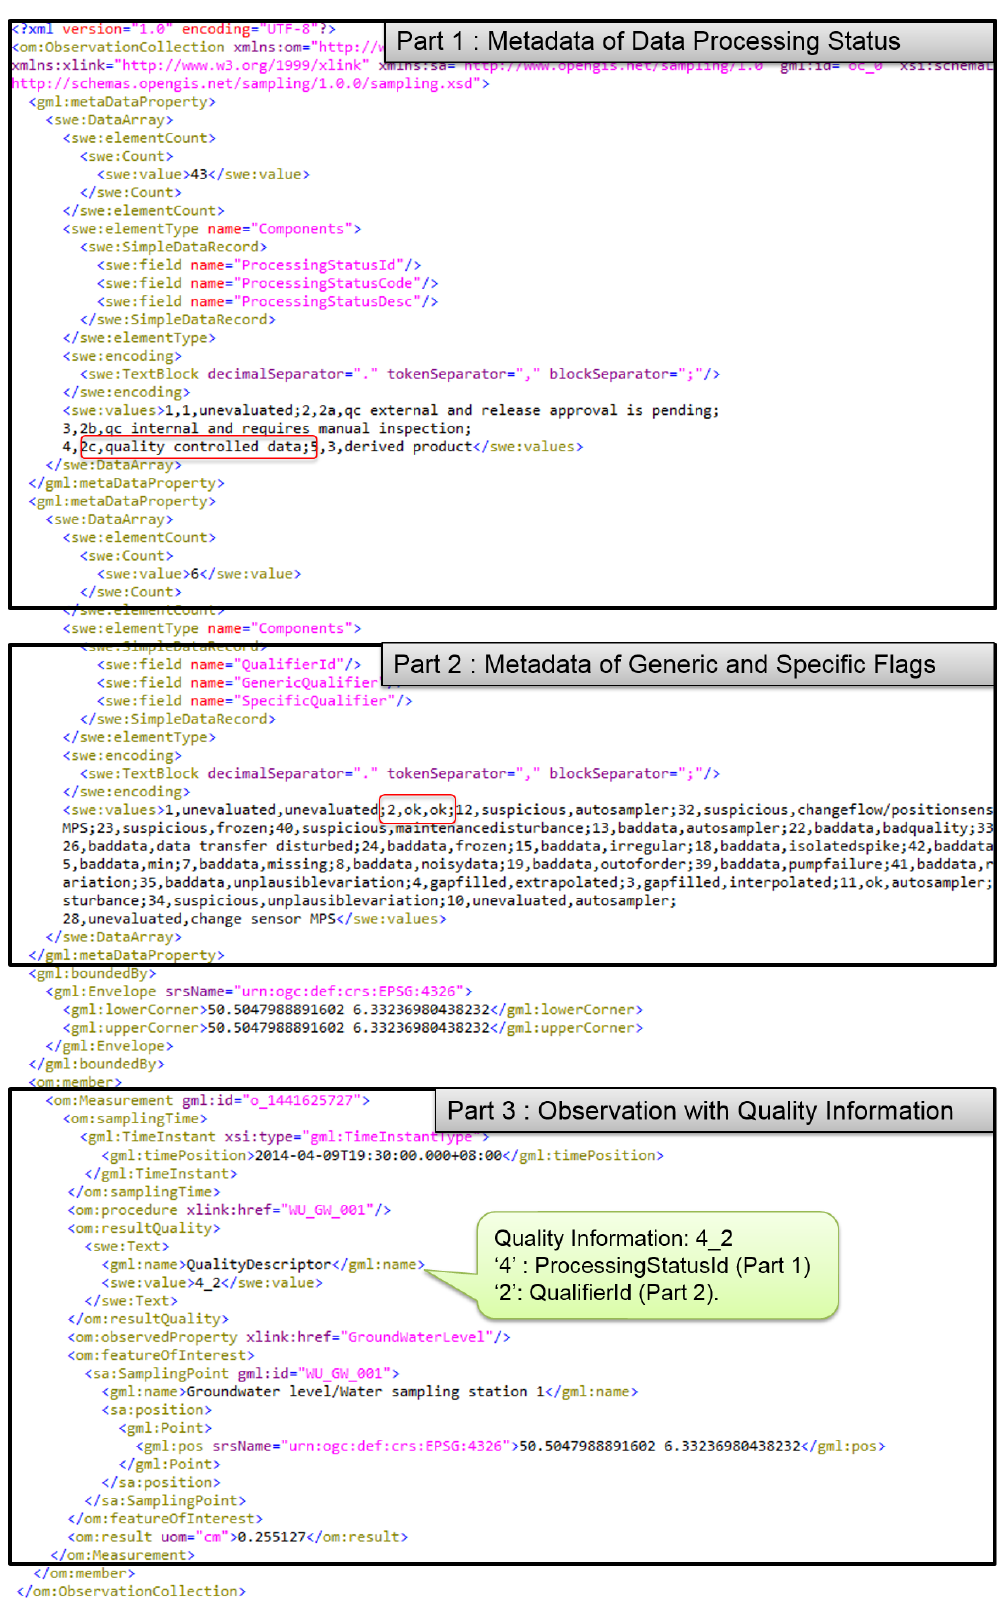
Figure 6. An example of O&M document produced by the Q-SOS that includes only fully quality assessed data (Level 2c) that are of good quality (“ok_ok”